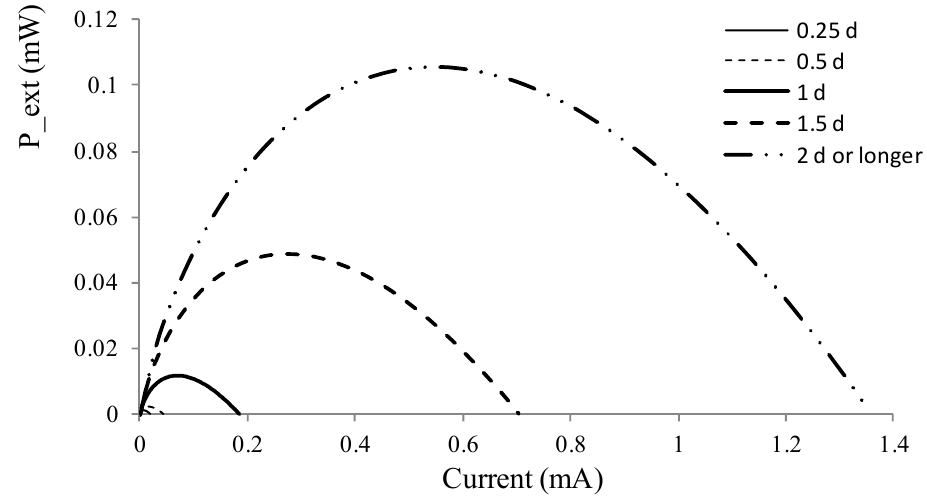
Figure 4. Simulated polarization curves at different moments of inoculation. Attached bacteria concentration reached a plateau value after about 2 d, and the polarization curves did not change much thereafter.